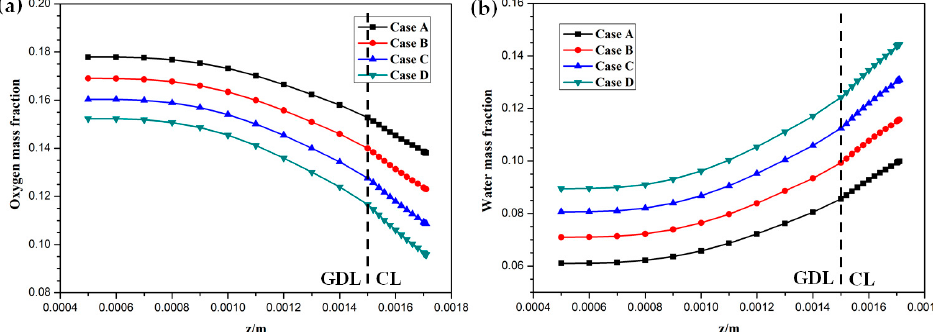
Figure 6. Species mass fraction profile distributions at y = 0.001 m (Case A: DL = 5; Case B: DL = 7;